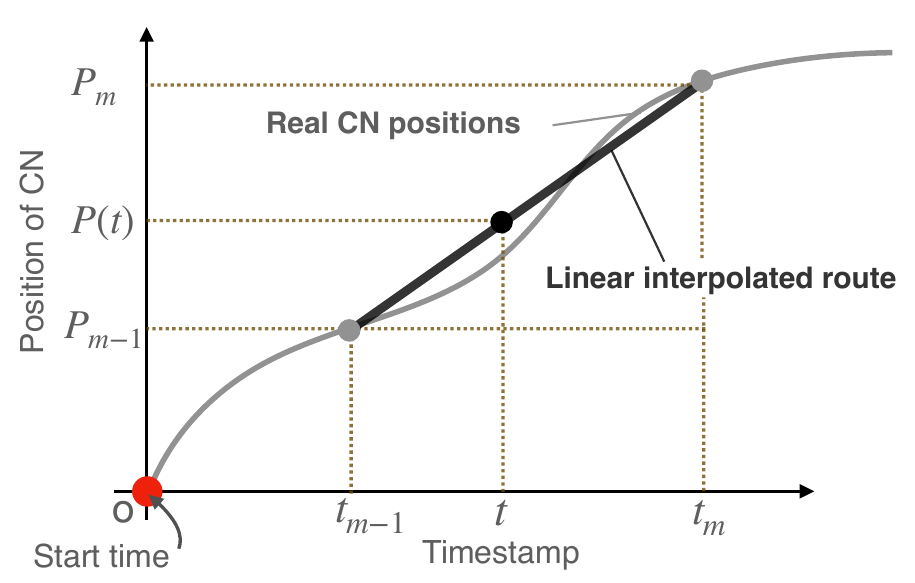
Figure 6. Linear interpolation using